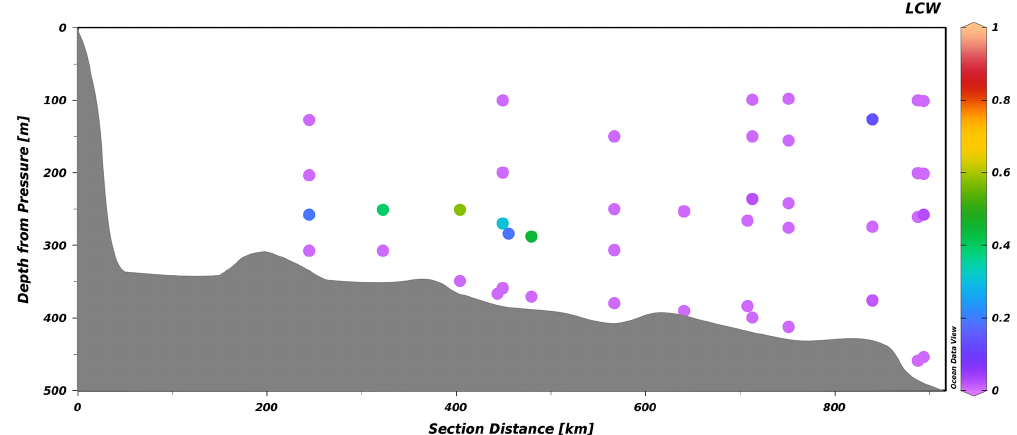
Figure 7. Transect of the LCW fraction along the Laurentian Channel from a survey conducted between 23 and 29 October 2021, from the head of the Laurentian Channel (left) to Cabot Strait (right). The slightly offset points depict stations located along transects perpendicular to the channel.